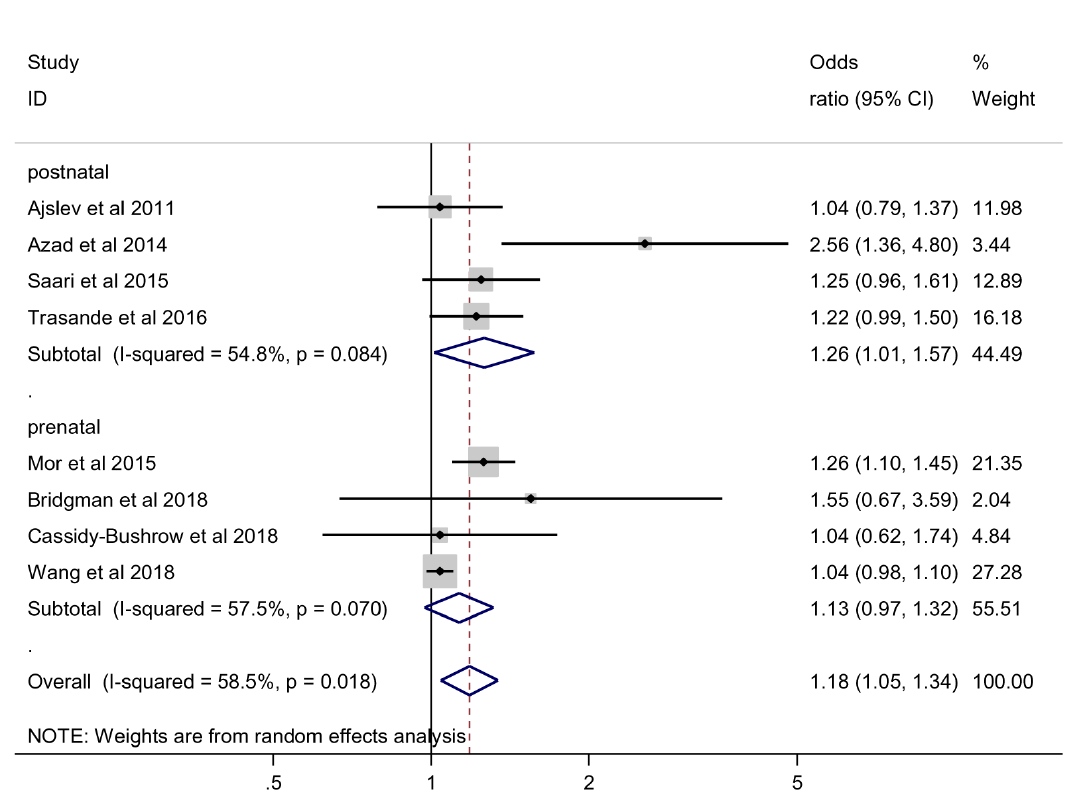
Figure 4. Overweight outcome, subgroup analysis by timing of